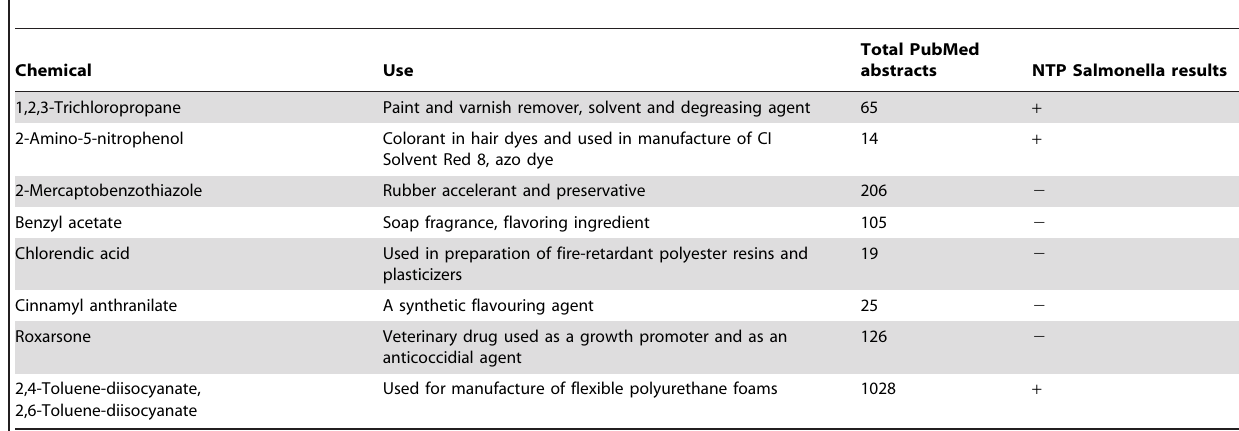
Table 1. Chemicals classified by NTP to be associated with site-specific tumor induction in pancreas acinar cell (pancreatic acinar cell adenoma or carcinoma) in male rats and their major